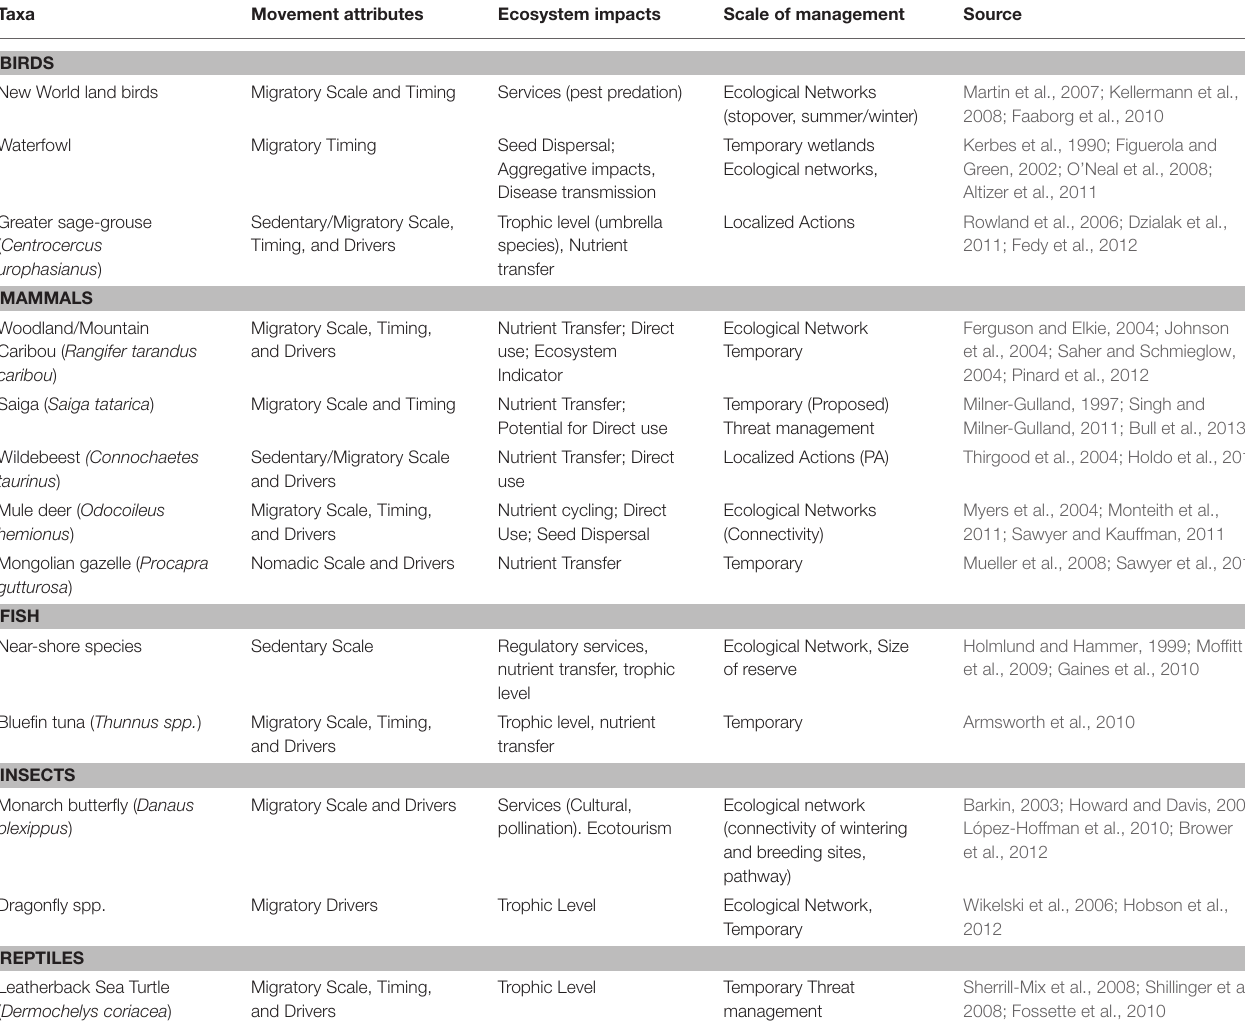
TABLE 1 | Links between movement ecology and wildlife